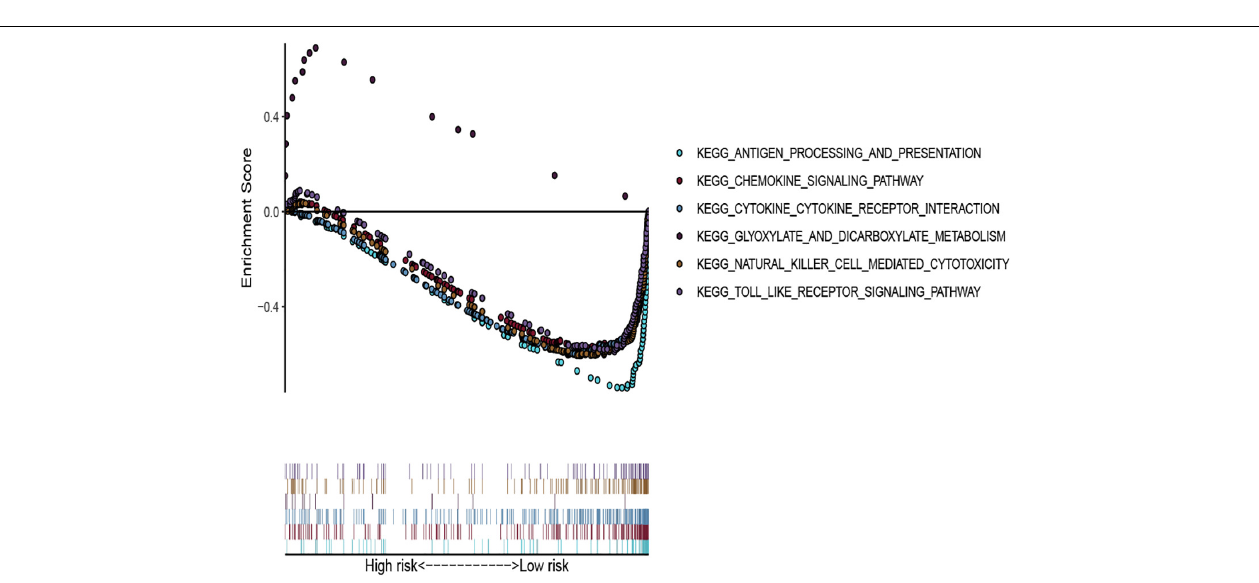
FIGURE 7 | The GSEA for EMT-related lncRNA signature in the whole